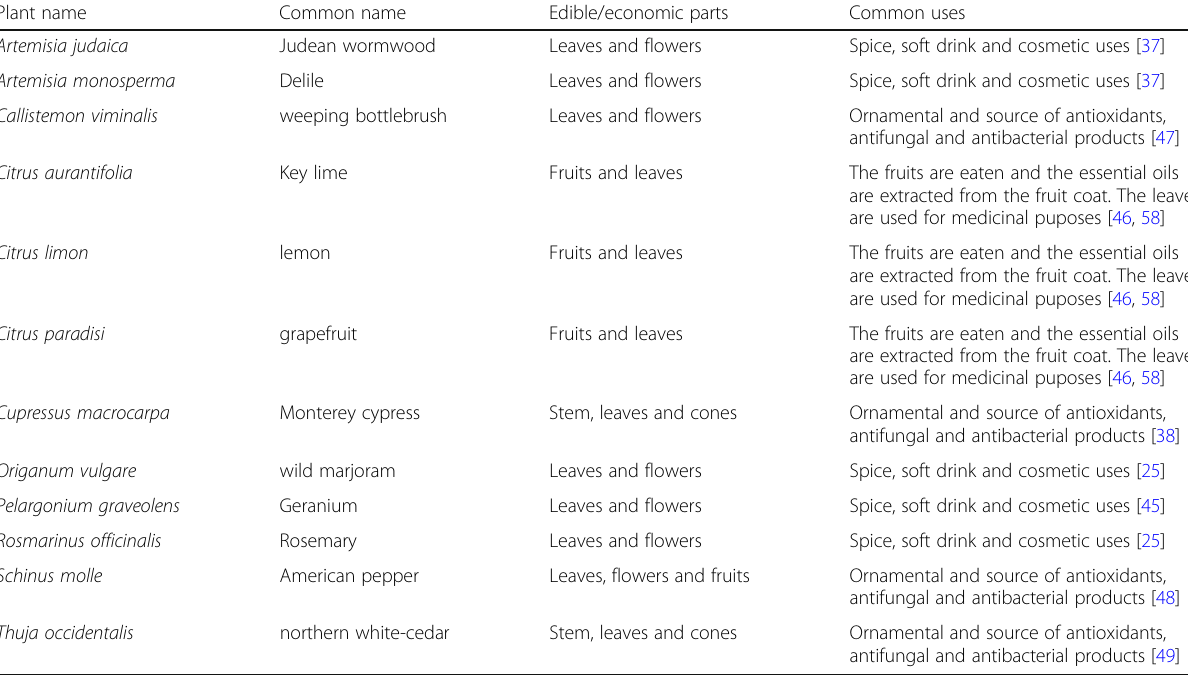
Table 8 Common names and edible parts of twelve ornamental and horticultural Egyptian plant